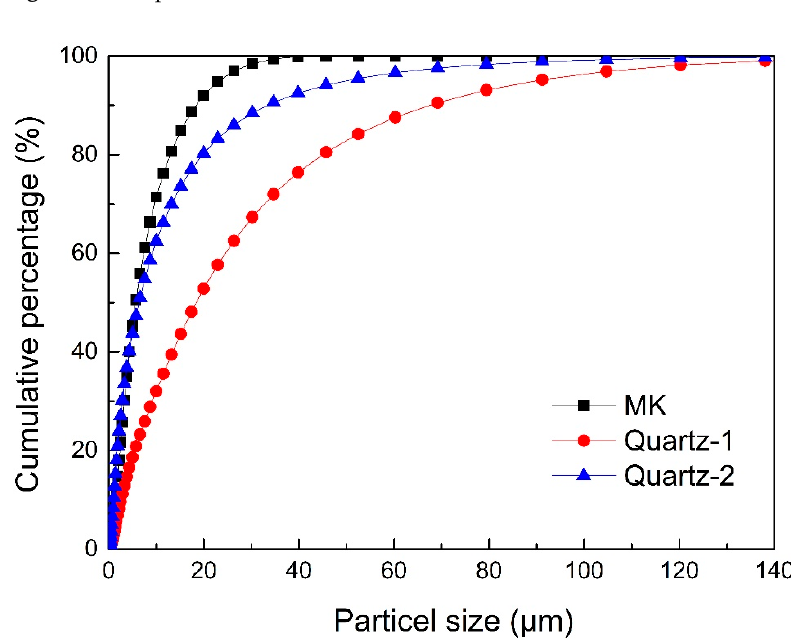
Figure 2. Particle size distributions of MK, quartz-1 and quartz-2.